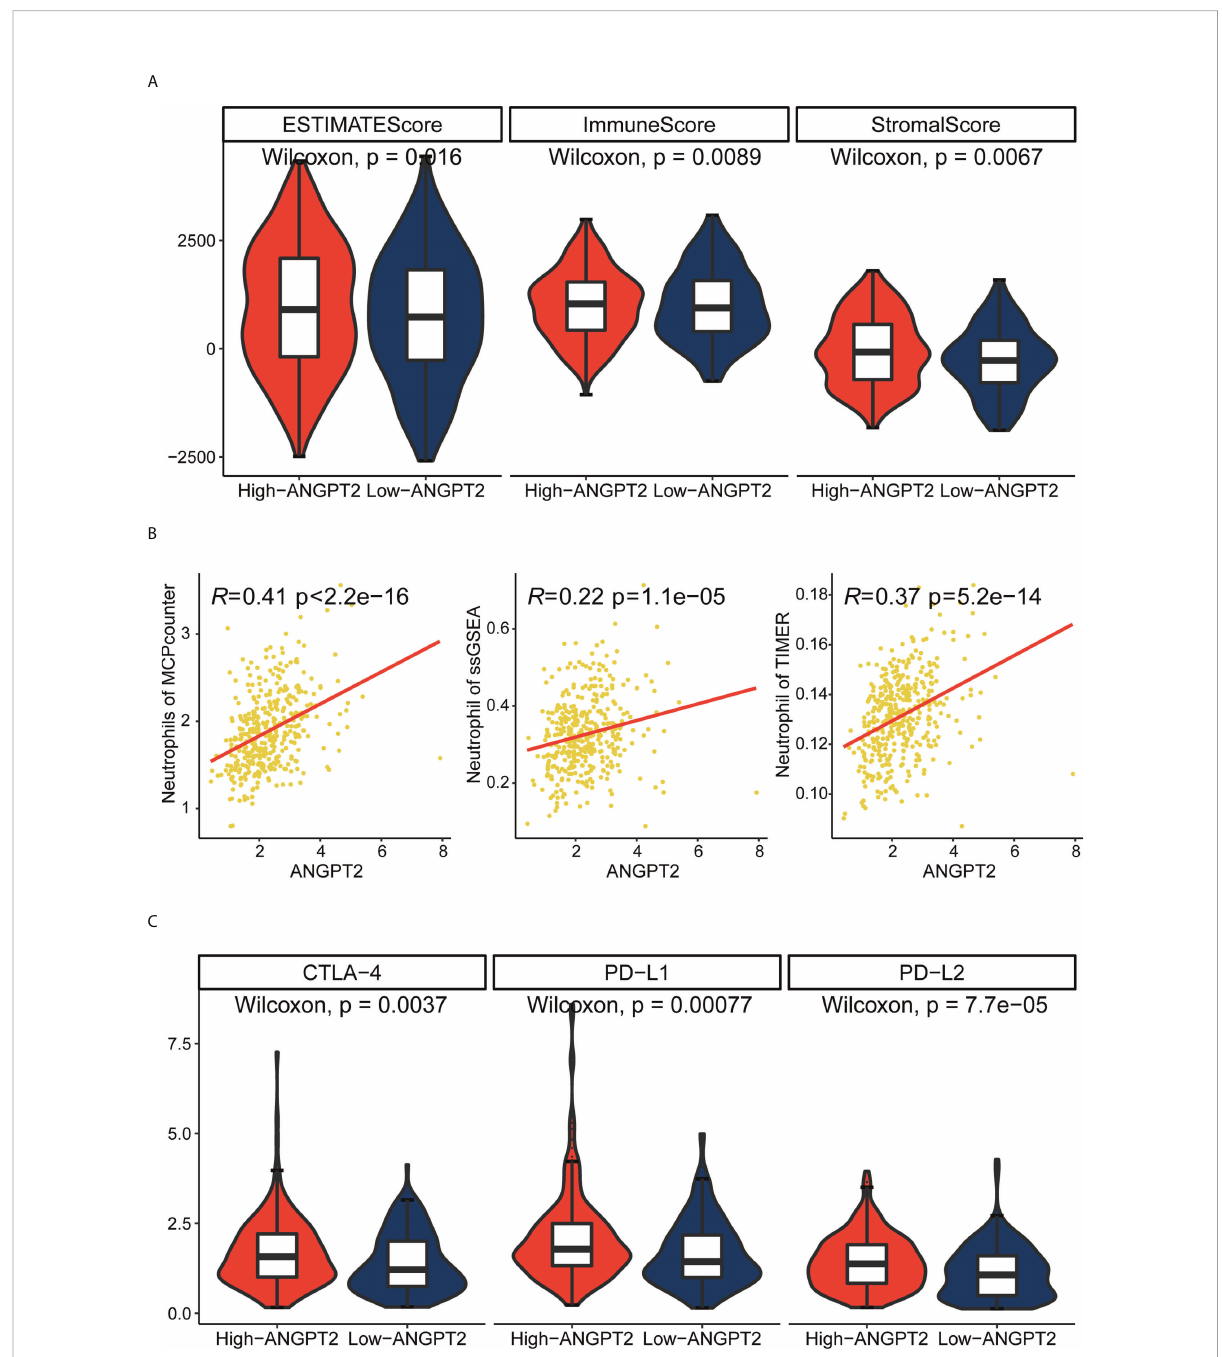
FIGURE 5 Relationship between ANGPT2 and immune characteristics in TCGA cohort. (A) Changes of ANGPT2 and ESTIMATE score, immune score, and stromal score. (B) Correlation between ANGPT2 and neutrophil cell in fi ltration level in three immune in fi ltration estimation algorithms. (C) The relationship between ANGPT2 and three classical immune